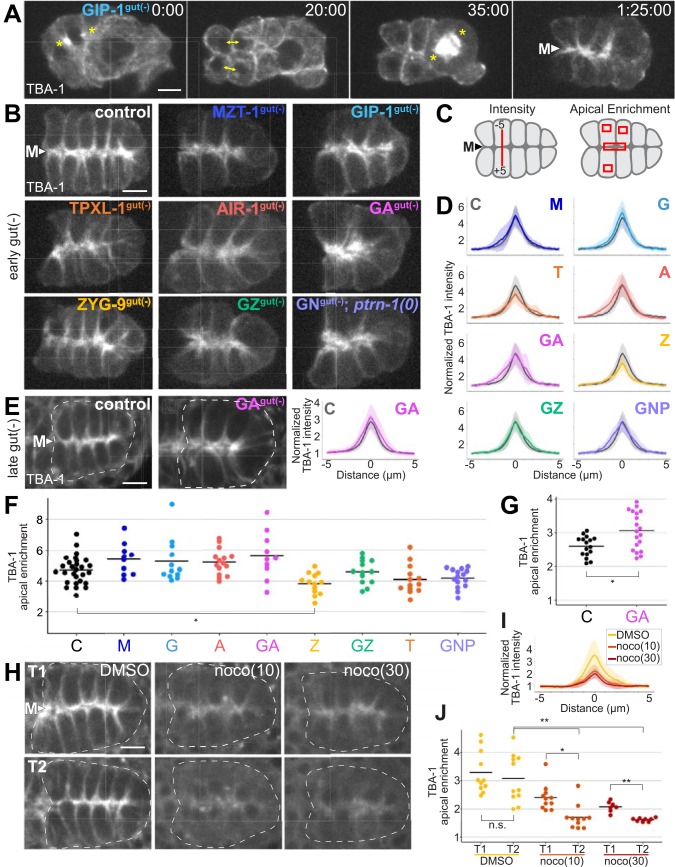
Apical microtubules persist following depletion of GIP-1, MZT-1, and/or AIR-1 and other microtubule regulators.(A) Still images from S1 Movie. Images show the final mitotic divisions before intestinal polarization and the appearance of the apical ncMTOC in a GIP-1gut(−) embryo. Centrosomes (asterisks) and sister cells (double-headed arrows) are indicated. Note that the posterior of this intestinal primordium contains one rather than four cells prior to division, yet apical microtubules still form at the midline (arrowhead and “M”). Time stamp indicates Hours:Minutes:Seconds (B, E, H) Projected 1.5 μm optical sections through the E16 intestinal primordium of embryos, with indicated genotypes expressing intestine-specific (B) or maternally expressed (E, H) mCherry::TBA-1/α-tubulin. (C) Cartoon summarizing measurements for intensity in D, E, I, and for apical enrichment in F, G, and J. (D, E, I) Normalized average TBA-1 pixel intensities along 10-μm line segments drawn across the apical midline of polarized intestinal primordia (n ≥ 10 embryos) for each indicated genotype with early gut(−) (D) and late gut(−) (E), and for control-treated (DMSO) and nocodazole-treated embryos (I). Light shaded regions show standard deviation. zif-1(−) control profiles are included in gray for reference (“C”). (F, G, J) Ratio of apical TBA-1 signal as compared to cytoplasmic levels for each indicated genotype with early gut(−) (F), late gut(−) (G), and nocodazole treatment (J). Each dot represents a single embryo of the indicated genotype and black bars indicate mean values for each genotype. No significant differences are observed between genotypes, except for a significant reduction in ZYG-9gut(−) embryos (p = 0.002) and a significant increase in [GIP-1;AIR-1]late gut(−) (p = 0.004), as compared to control. (H, I, J) Images are 1.5 μm projected optical sections through the E16 intestinal primordium of embryos treated with DMSO (control), or with 10 μg/mL or 30 μg/mL nocodazole (noco(10) and noco(30)) within 1 minute of treatment (T1) and 10 minutes later (T2). mCherry::TBA-1 intensity (I) and apical enrichment (J) are indicated for each case. Each dot represents a single embryo of the indicated genotype and black bars indicate mean values for each genotype. Comparing T1 to T2: DMSO, p = 0.54; noco(10), p = 0.002; noco(30), p = 0.0004. Comparing T2 control to T2 treatment: noco(10), p = 0.0003; noco(30), p = 0.0002. In F, G, and J, *p < 0.01, **p < 0.001 by two-tailed t test. Scale bar is 5 μm for all images. A, AIR-1gut(−); C, zif-1(−) control; G, GIP-1gut(−); GA, [GIP-1; AIR-1]gut(−); GNP, [GIP-1; NOCA-1]gut(−); ptrn-1(0); GZ, [GIP-1; ZYG-9]gut(−); M, MZT-1gut(−); ncMTOC, non-centrosomal microtubule organizing center; T, TPXL-1gut(−); Z, ZYG-9gut(−).